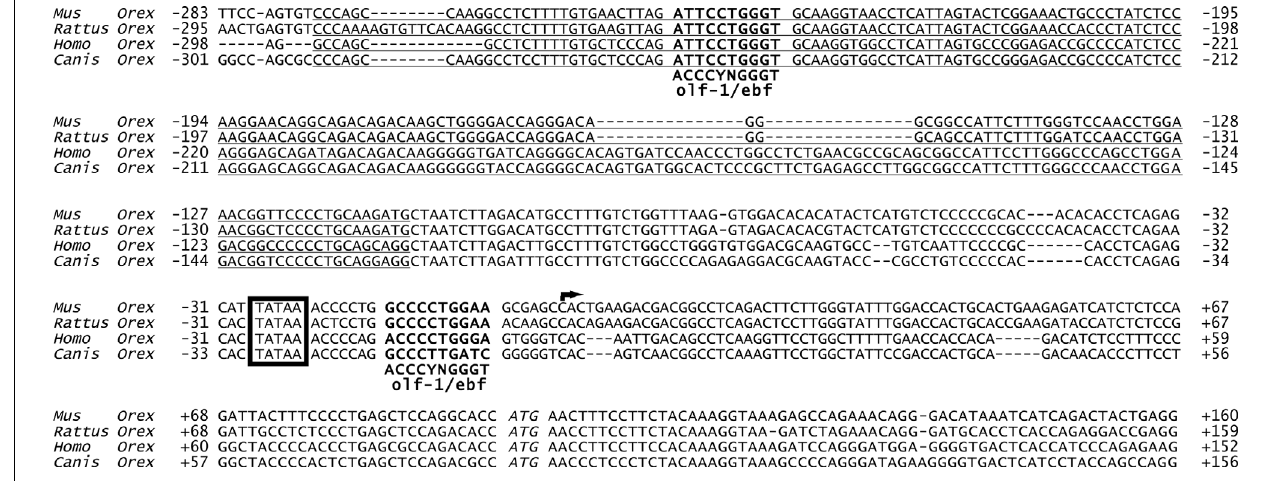
FIGURE 2 | Presence of olf-1 (O/E3 binding site) like elements in the promoter region of prepro-orexin genes. Alignment of the upstream (283–300bp) sequences of the prepro-orexin (prepro-hypocretin) locus (Hcrt) from four separate mammals shows two highly conserved olf-1-like (olf-1/ebf, bold face) elements.The consensus olf-1 sequence, depicted under the alignments, was identified as an OE1 binding site in genes expressed in the